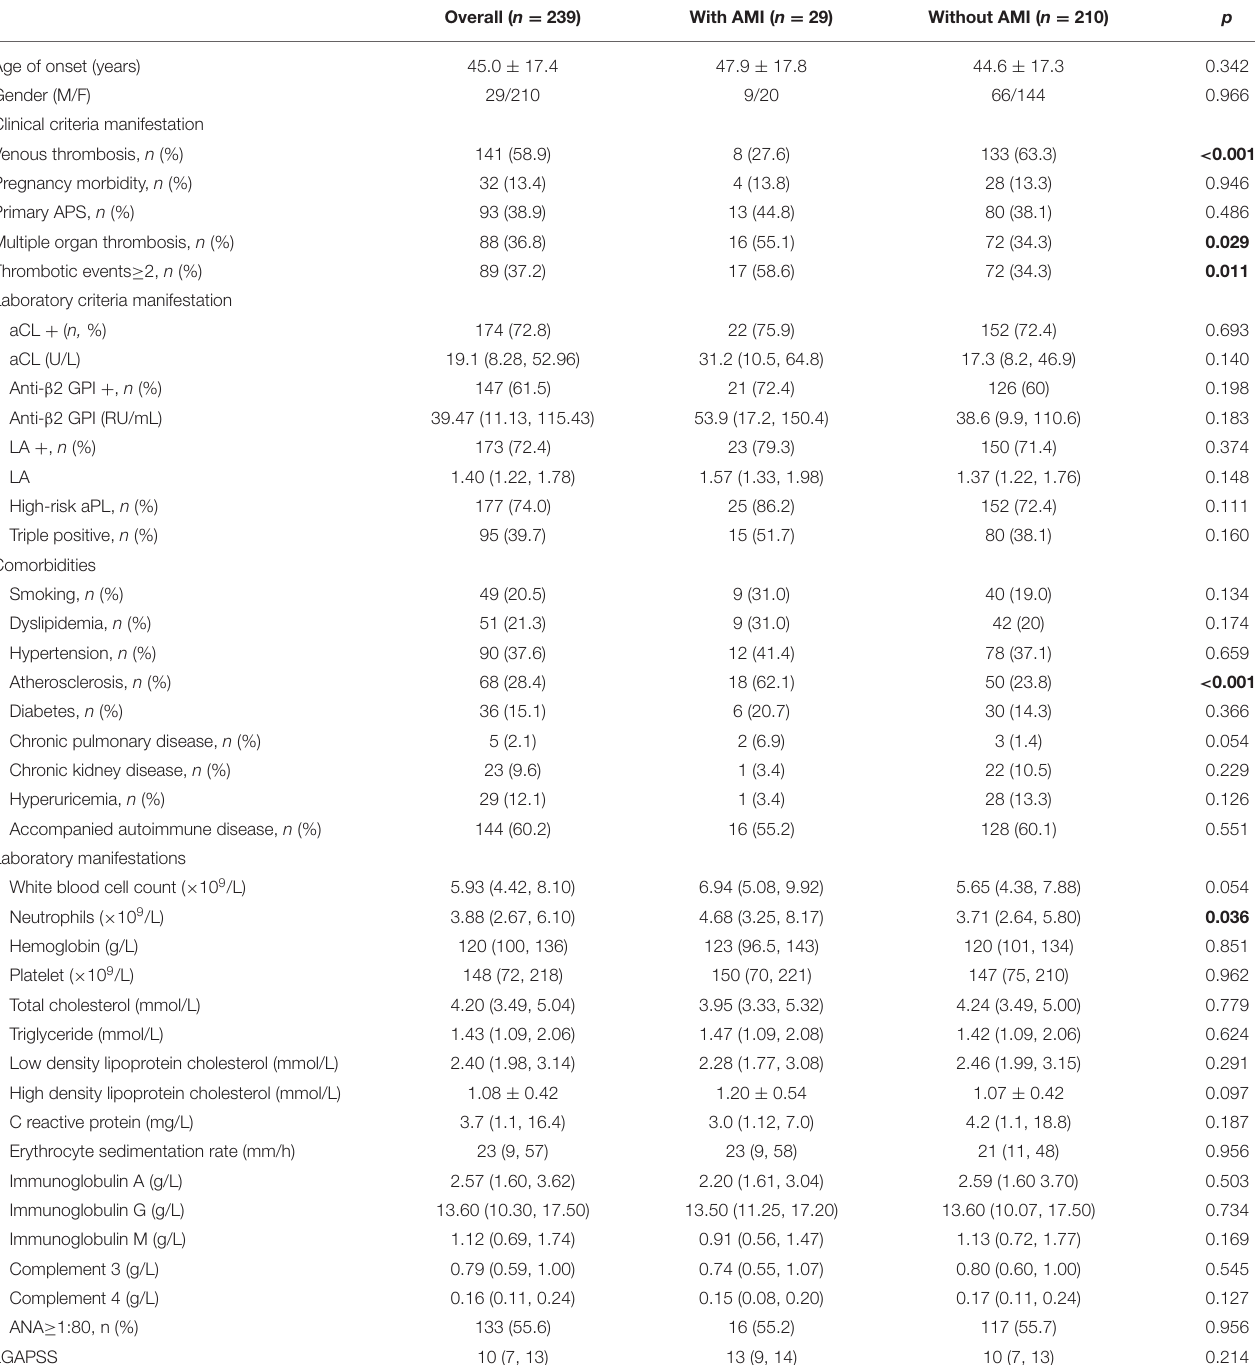
TABLE 2 | Baseline characteristics of APS patients with or without AMI. Overall ( n = 239) With AMI ( n =